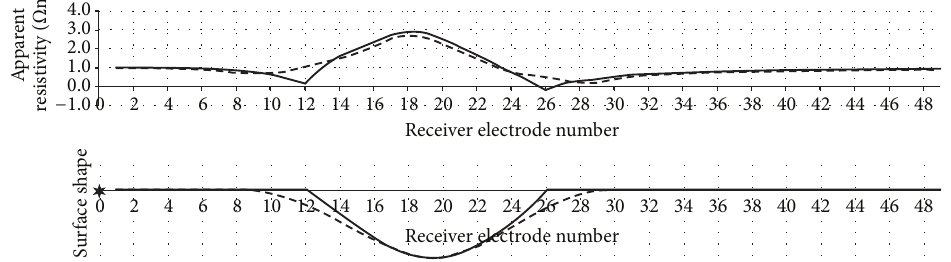
Figure 4: The shape of the simulated ground surface and 𝜌 𝑎 curves, for a three-electrode array on a hemispherical recess surface. A star indicates the position of the current source electrode. — indicates surface with sharp angles; ---- indicates surface with smooth